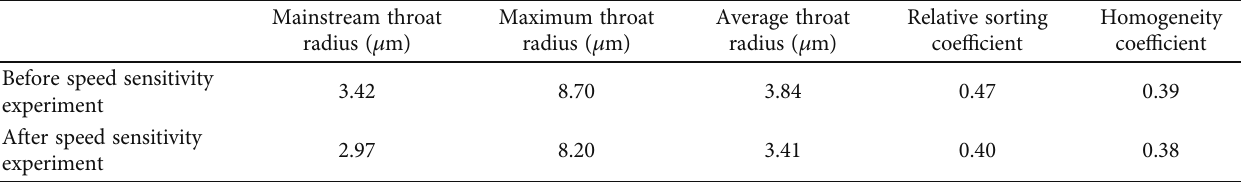
Table 5: Throat data before and after the D1 core